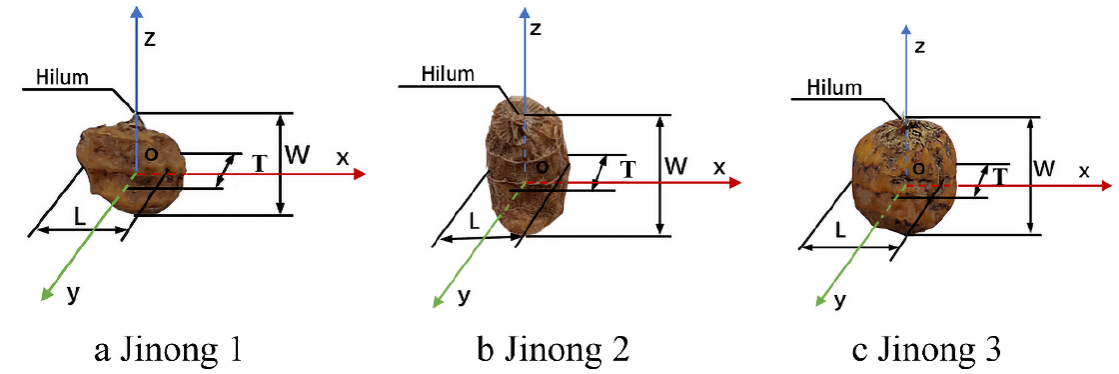
Figure 1. Tri-axial dimensions and reference coordinate system of the Cyperus esculentus seeds. Table 1. Density, moisture content and thousand seed weight of the Cyperus esculentus seeds. Variety Density Moisture Content Thousand Seed Weight Jinong 1